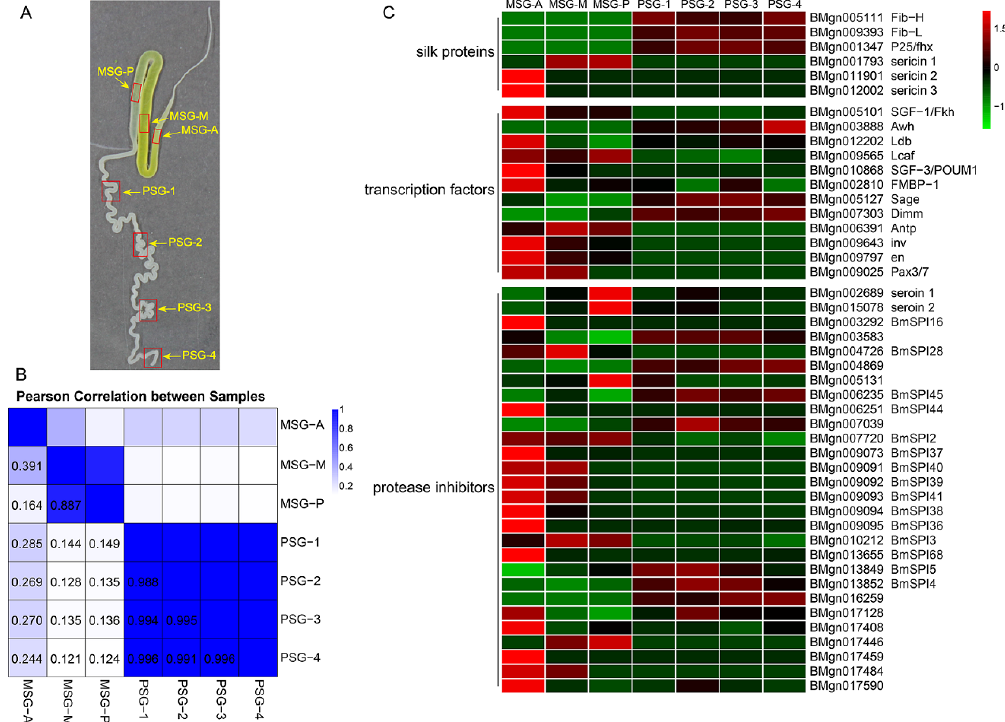
Figure 1 . Overview of samples and transcriptome data. ( A ) Silk gland at full maturation of 5th instar. The single silk gland was divided into MSG-A (anterior segment of the middle silk gland), MSG-M (middle segment of the middle silk gland), MSG-P (posterior segment of the middle silk gland), PSG-1, PSG-2, PSG-3, and PSG-4. Red boxes indicate where the samples were collected. ( B ) Pearson correlation analysis of samples. The number is the correlation coefficient between each two samples. ( C ) Heatmap of silk protein-related genes, including silk protein genes, transcription factors, and protease inhibitors.